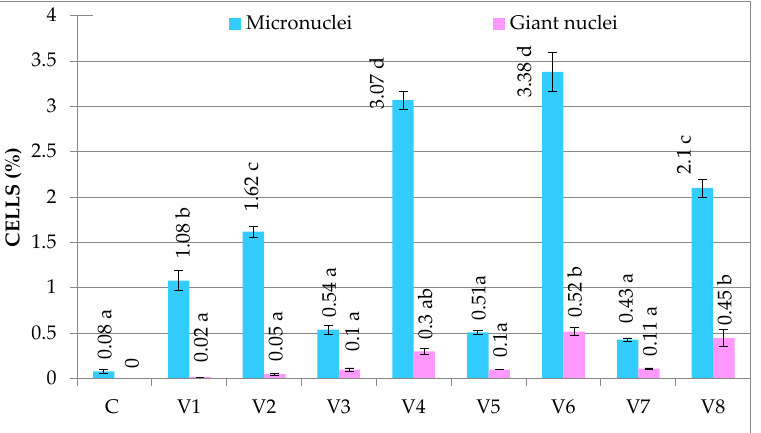
Figure 3. Frequency of genetic abnormalities in wheat root meristem ana-telophases induced by non-thermal plasma-activated water treatment. Bars are means of three replicates/experimental var- iant ± SD. The letters (a–e) show significant differences, p < 0.05.